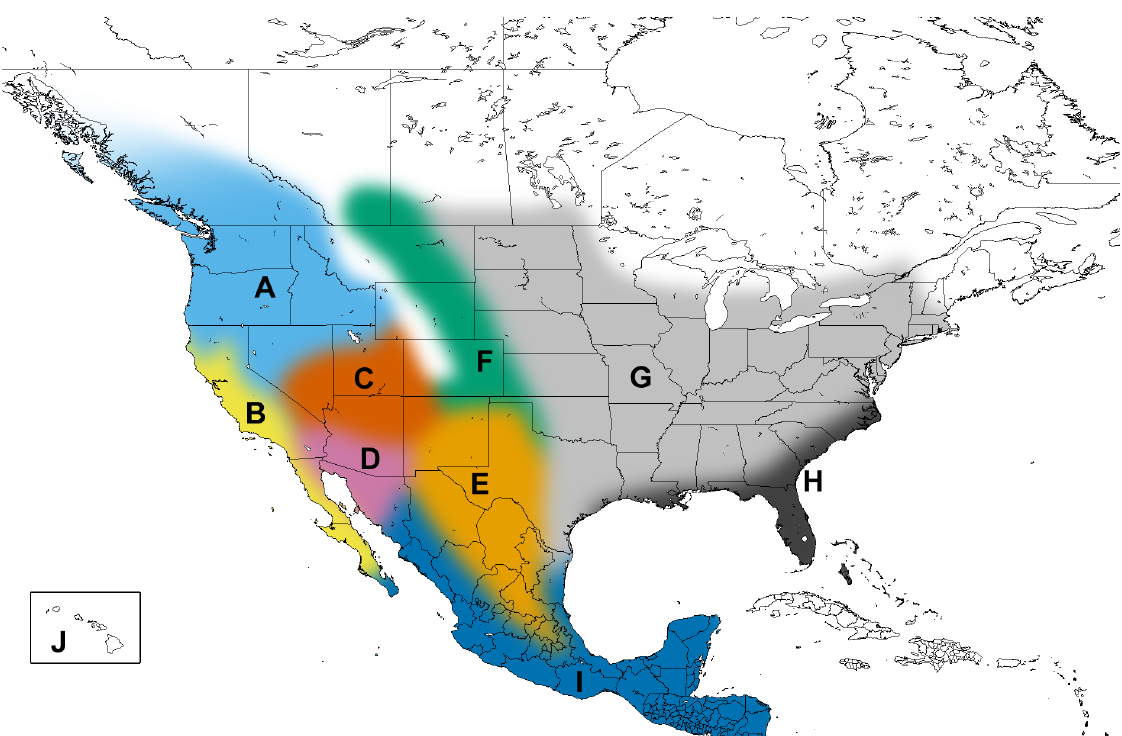
Fig. 77. Major geographic regions with distinct Lasioglossum gemmatum species complex fauna. Borders are intentionally blurred because the limits of these regions are approximate and spillover near transition zones is well-known. A . Cascadia (also including northern Great Basin). B . California. C . High desert (including southern Great Basin, Mojave Desert, and Colorado Plateau). D . Western low desert (including Sonoran Desert and western Chihuahuan Desert). E . Eastern low desert (including most of Chihuahuan Desert). F . Western Great Plains. G . Eastern. H . Southeastern. I . Neotropical. J .